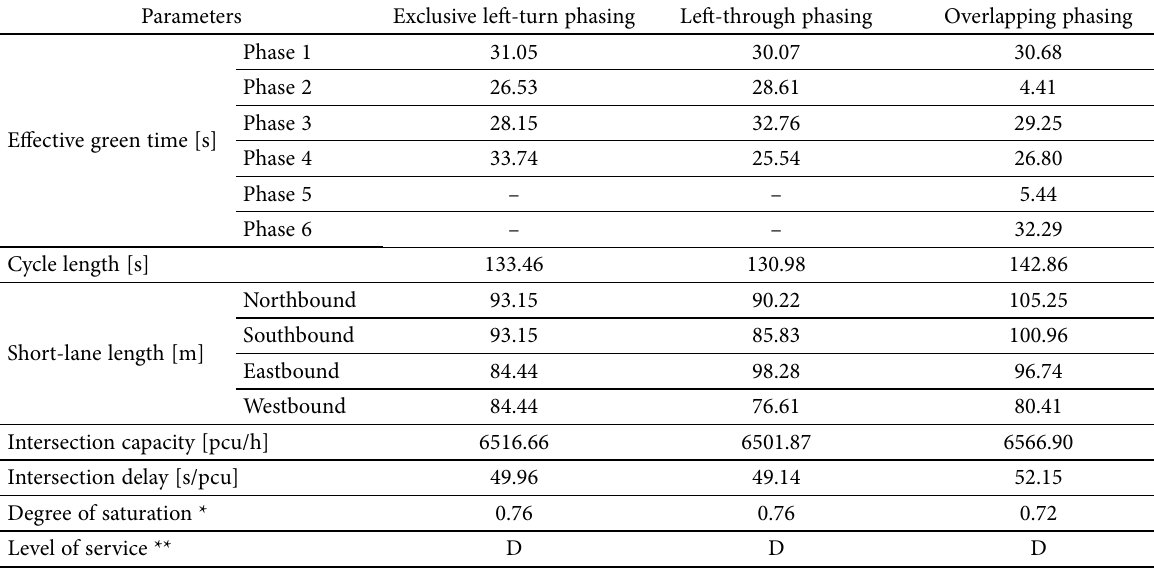
Table 2. Optimization outcomes under different signal phase plans